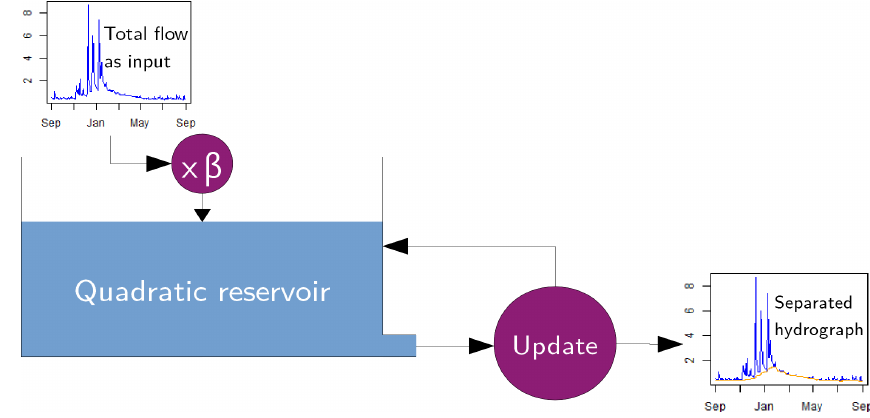
Figure 1. Synthesis of the filtering algorithm.